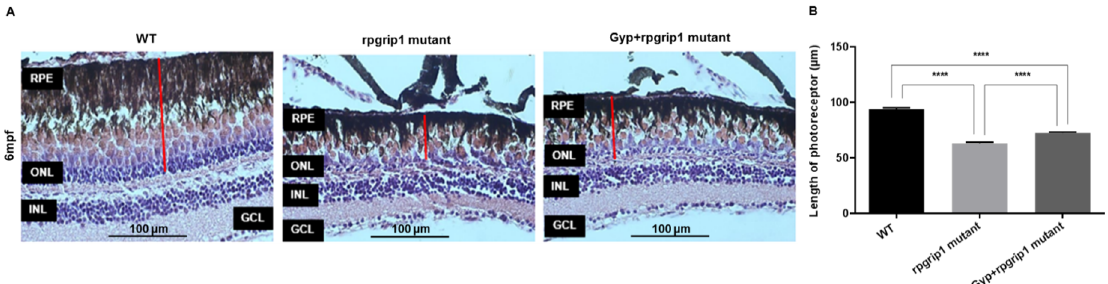
Figure 1. ( A ) Hematoxylin and eosin-stained image of retinal sections of wildtype (WT), rpgrip1 mutant and Gyp-treated rpgrip1 mutant zebrafish at 6 mpf. ( B ) Thickness of photoreceptor layer of the three zebrafish groups. Statistical comparisons between individual groups were carried out using one-way ANOVA followed by Bonferroni’s test. Data are displayed as mean ± SEM ( n = 5 animals of each group). **** p < 0.0001. INL, inner nuclear layer; GCL, ganglion cell layer; ONL, outer nuclear layer; RPE, retinal pigment epithelial cells.